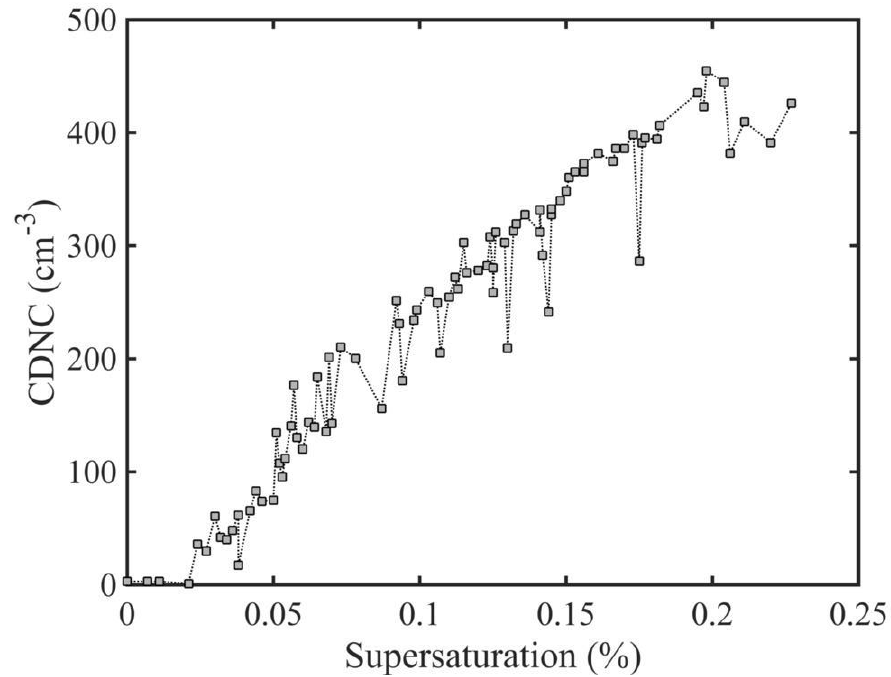
Figure A1. CDNC measured within the CHIEF cloud chamber as a function of supersaturation.